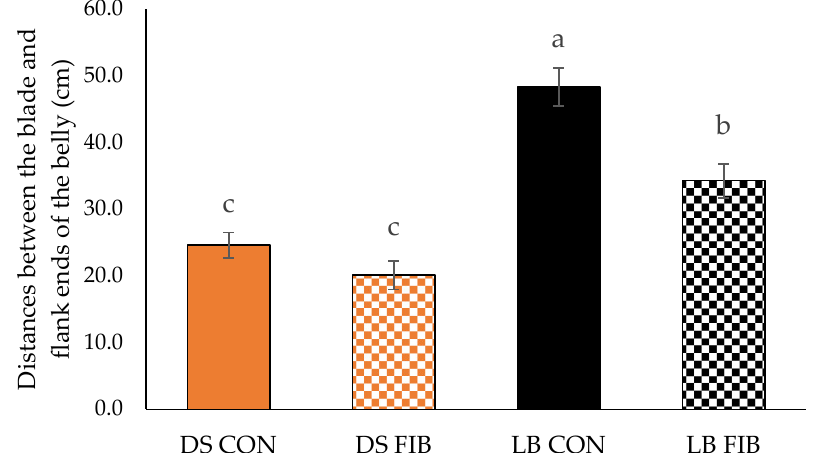
Figure 4. Effect of breed × diet interaction on belly firmness by the distance between the blade and flank ends of the belly placed skin-side down on a stationary PVC pipe (diameter = 8.89 cm). CON = diet of corn–soybean meal, DDGS-based; FIB = diet using increasing amounts of wheat middlings (1–10%) and dehydrated alfalfa meal (7.5–20%) to replace corn and soybean meal in the CON diet. DS = Duroc-sired and LB = Large Black pigs. a,b,c Means with different superscripts differ ( p =